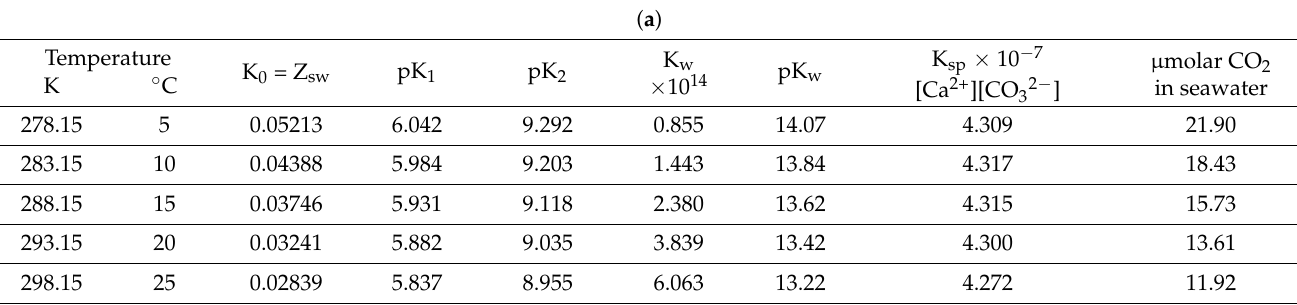
Table 1. ( a ) Estimated variation with temperature of equilibrium constants used for modelling of surface seawater at p CO 2 air 420 ppmv; ( b ) Standard enthalpy, Gibbs energy and entropy changes for the K 1 and K 2